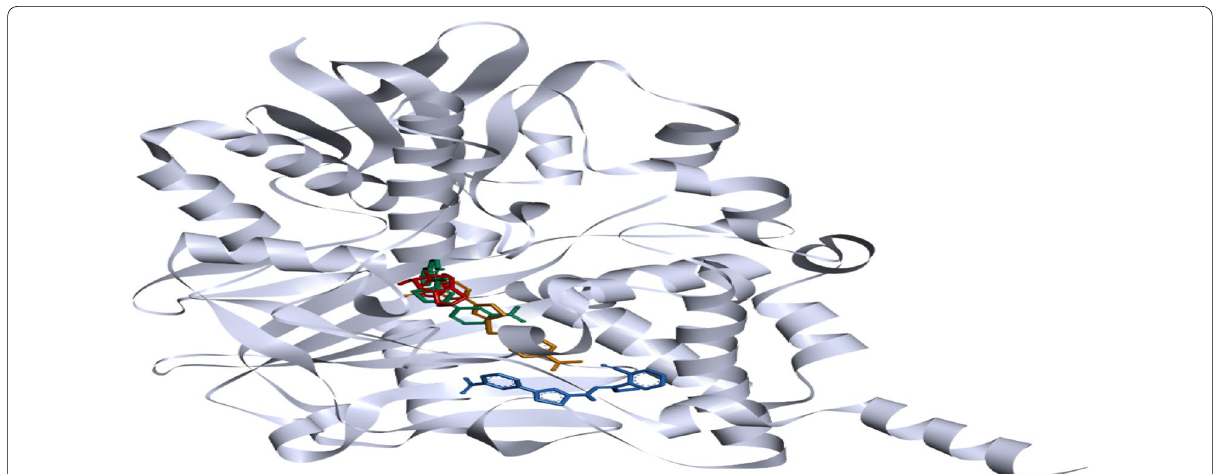
Fig. 7 Binding of the compounds inside the inhibitor binding site of the protein. Blue: compound 13, orange: compound 31, green: compound 33, and red: